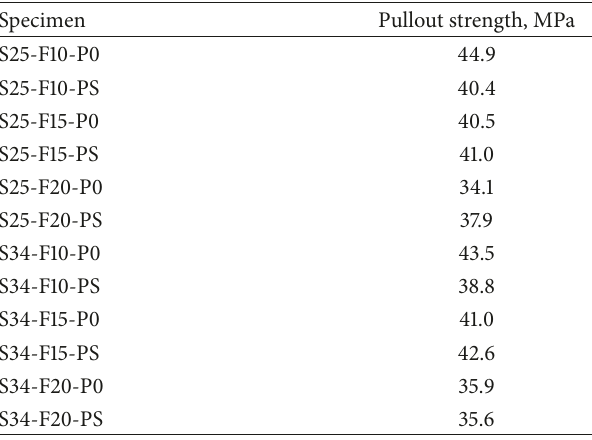
Table 3: Pullout strength of a fiber in UHPFRC evaluated through the inverse